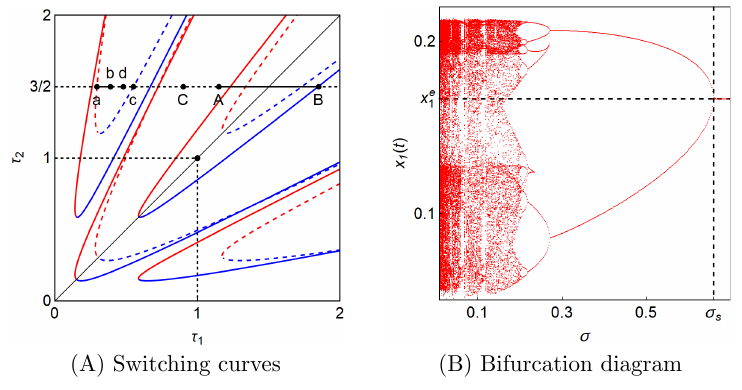
Figure 4. Stabilizing effect of σ